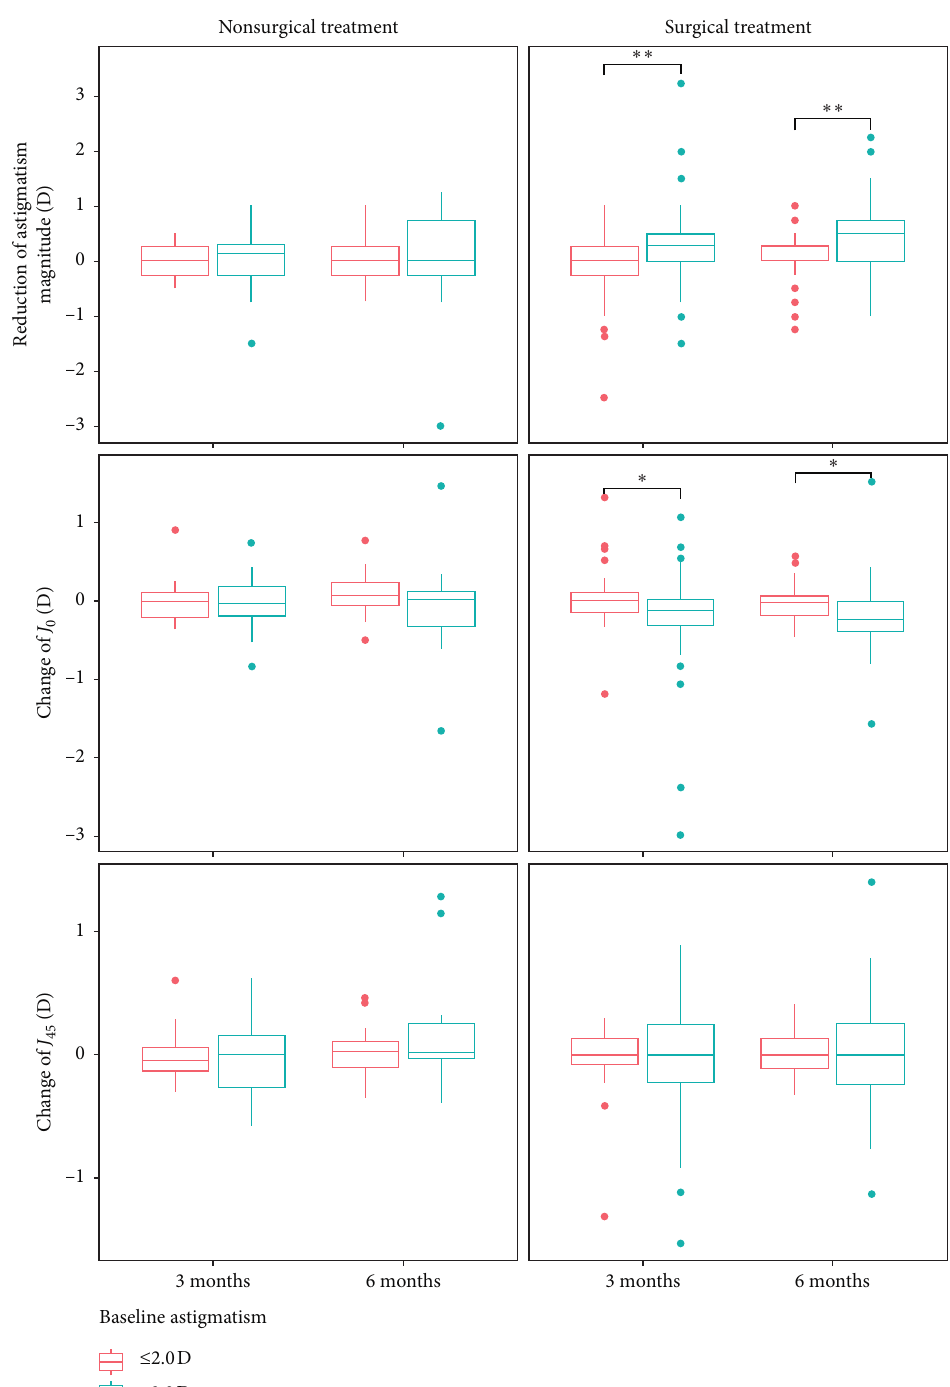
Figure 3: Change of astigmatism magnitude, J 0 and J 45 of the two study groups at postoperative 3 and 6 months, stratified by baseline astigmatism magnitude ( ≤ 2.0 and > 2.0 diopters). ∗ p value < 0.05; ∗∗ p value <